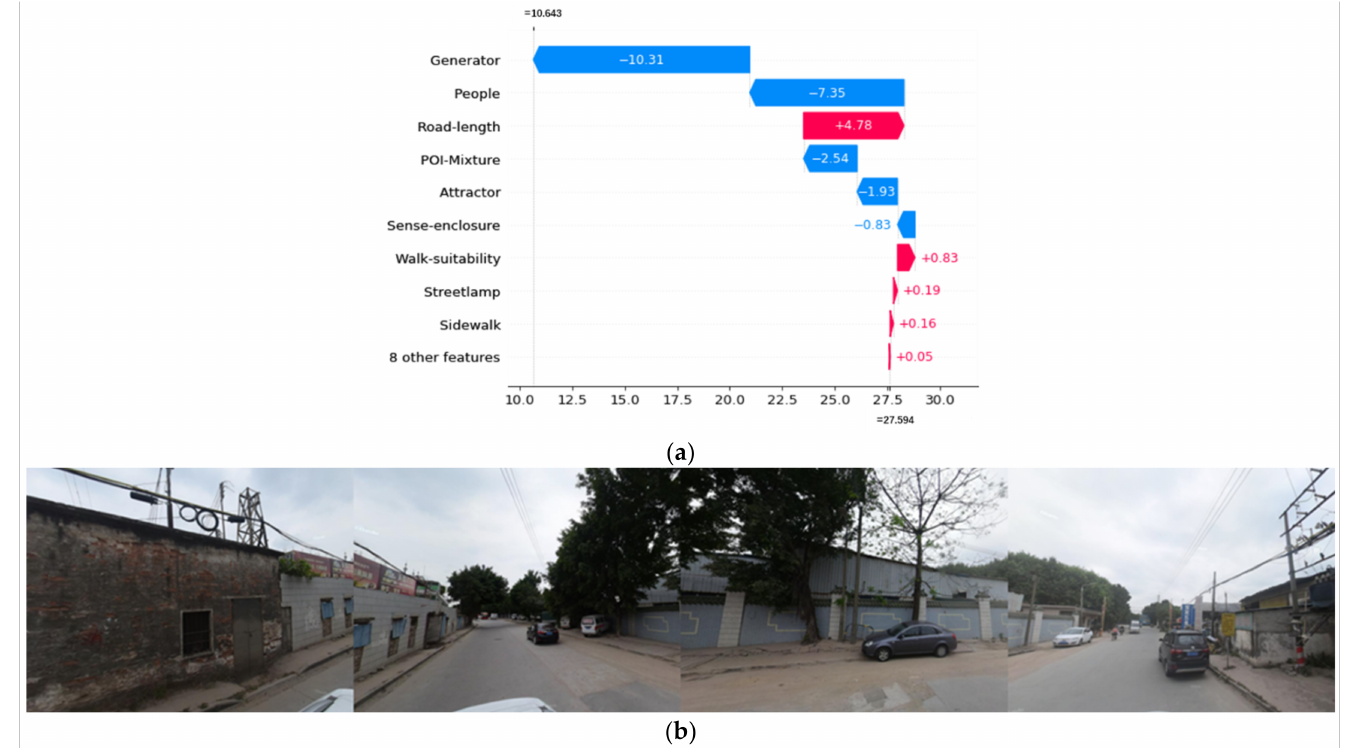
Figure 8. Local SHAP values of the features of the street segment with the smallest frequency of street property crime. ( a ) Local SHAP value. ( b ) Examples of street-view